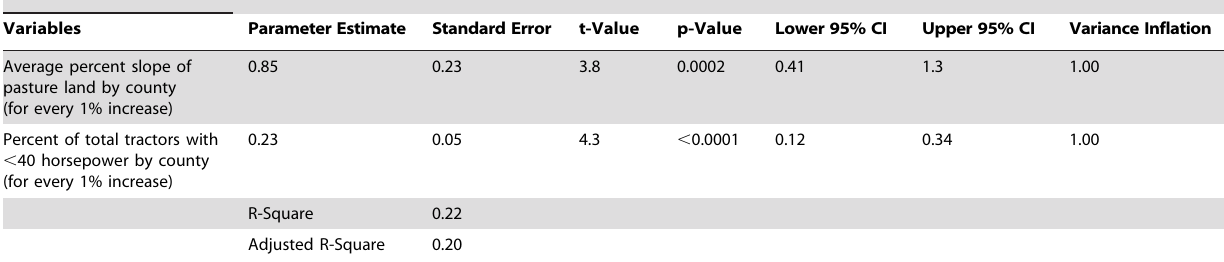
Table 5. Final multiple linear regression